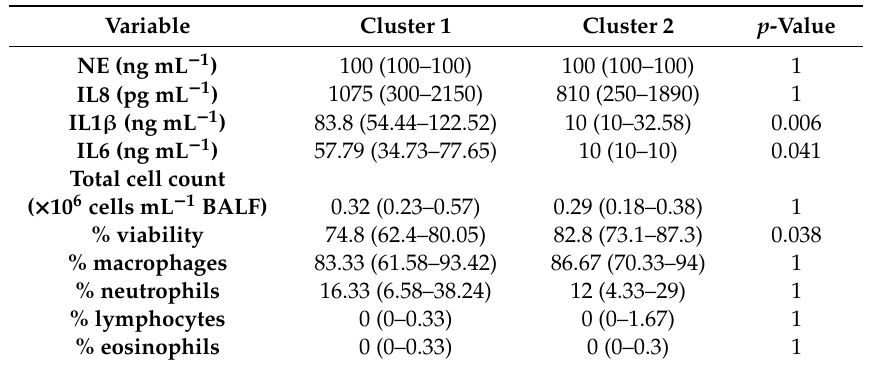
Table 1. Quantification of inflammatory markers and white cell composition in the BALF samples analysed in this study. Data represents the median value and the interquartile range (1st quartile-3rd quartile) of each variable per cluster. Mann-Whitney test was used for pairwise comparisons between group levels. Family-wise error rate was controlled using Bonferroni-corrected p -values.